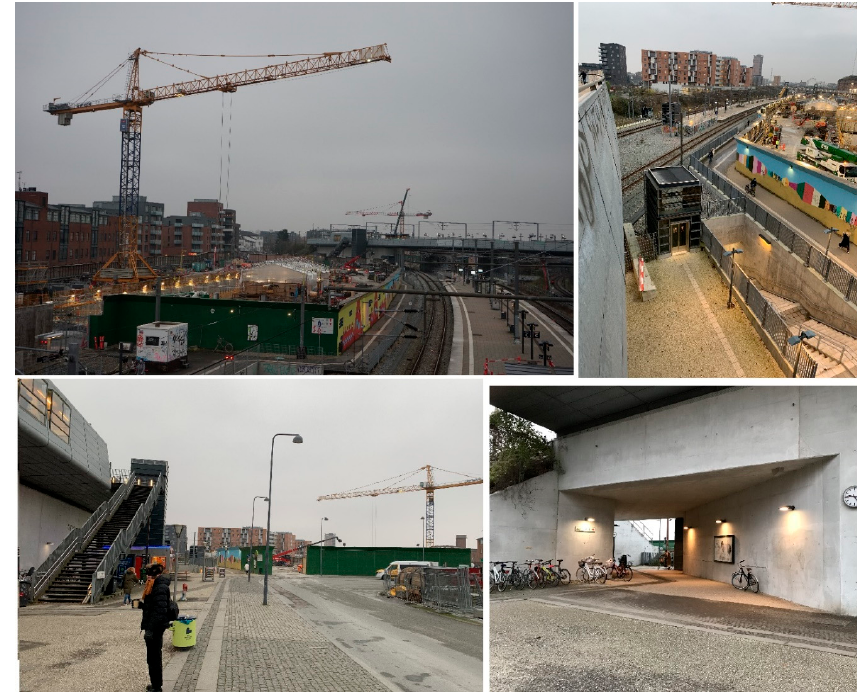
Figure 1. Images of the NES site in February 2021.